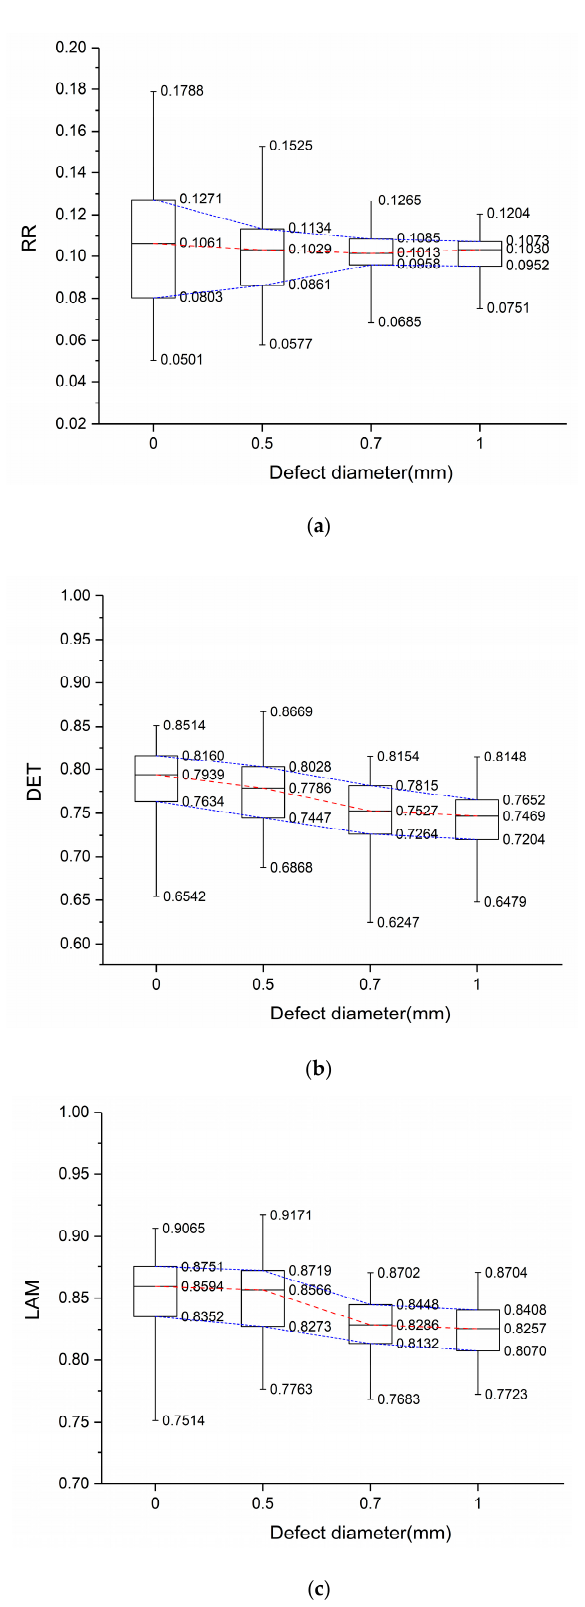
Figure 13. Statistical results of RQA variables of defect and defect-free areas: ( a ) RR; ( b ) DET; and, ( c ) LAM.